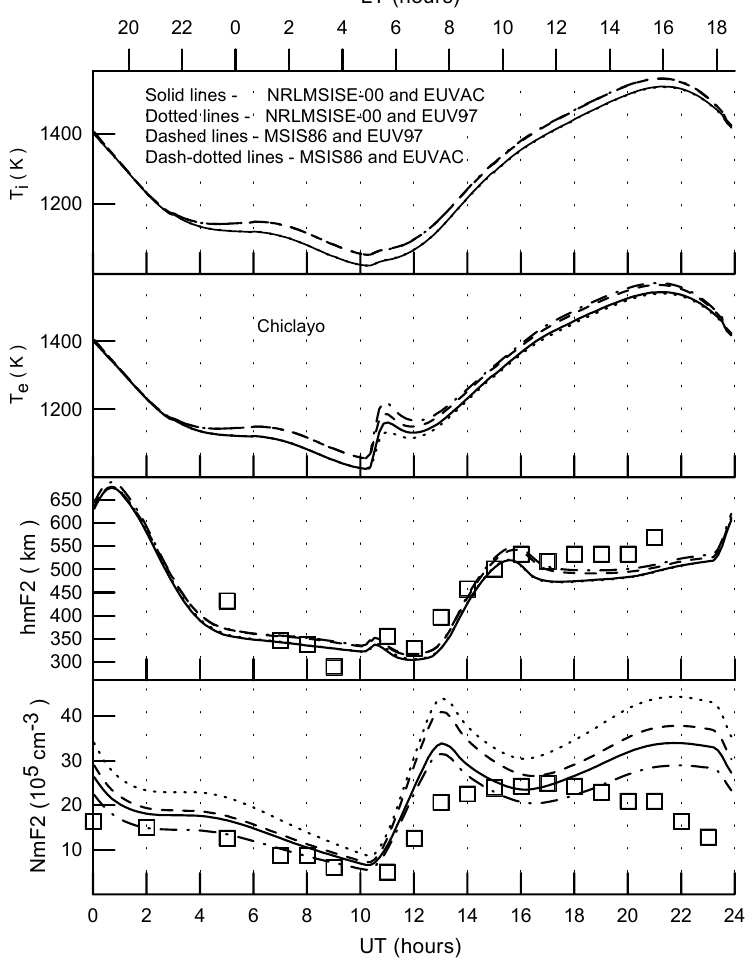
Fig. 4. From bottom to top, ob- served (squares) and calculated (lines) of Nm F2, hm F2, electron temperatures and O + ion temperatures at the F2- region main peak altitude above the Chiclayo ionosonde station on 7 Octo- ber 1957. LT is the local time at the Chiclayo ionosonde station. The curves are the same as in Fig.